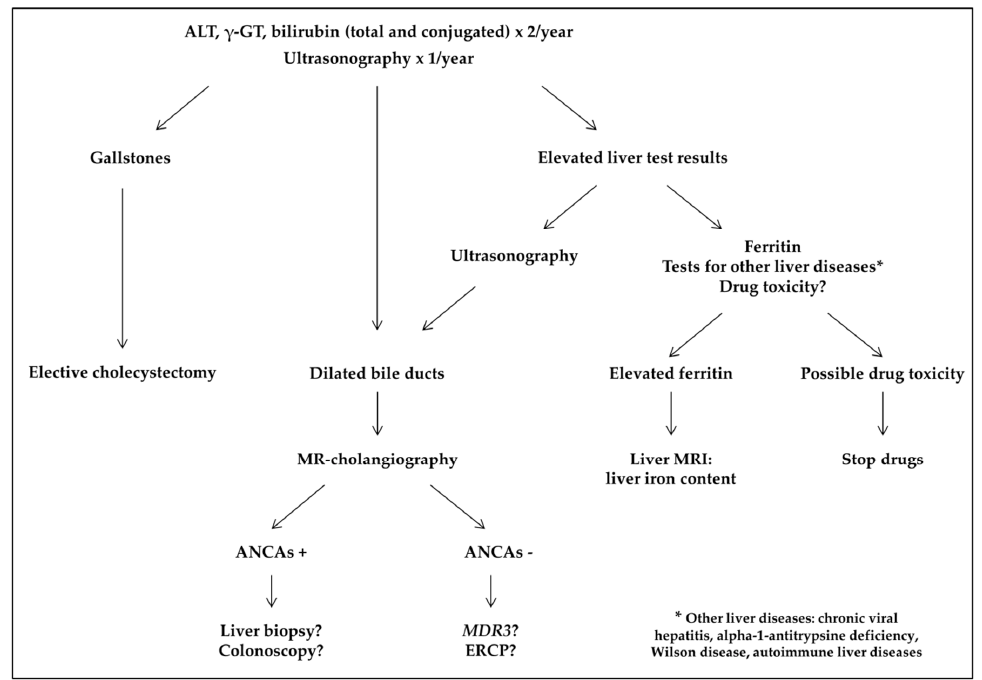
Figure 4. Screening for chronic hepatobiliary complications. ALT: alanine aminotransferase; ANCAs: antineutrophil cytoplasmic antibodies; ERCP: endoscopic retrograde cholangiopancreatography; MDR3 : multidrug resistance protein 3; γ -GT: